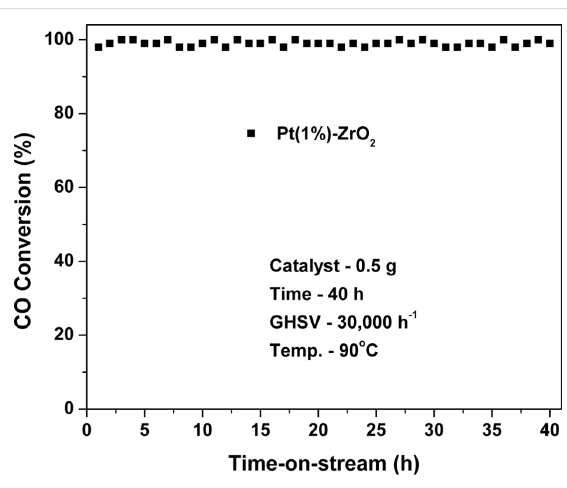
Figure 9: Time-on-stream stability test of Pt(1%)-ZrO 2 for CO conver- sion (catalyst: 0.5 g, CO: 500 ppm, O 2 : 20% Ar balance, GHSV: 30,000 h − 1 , T = 90